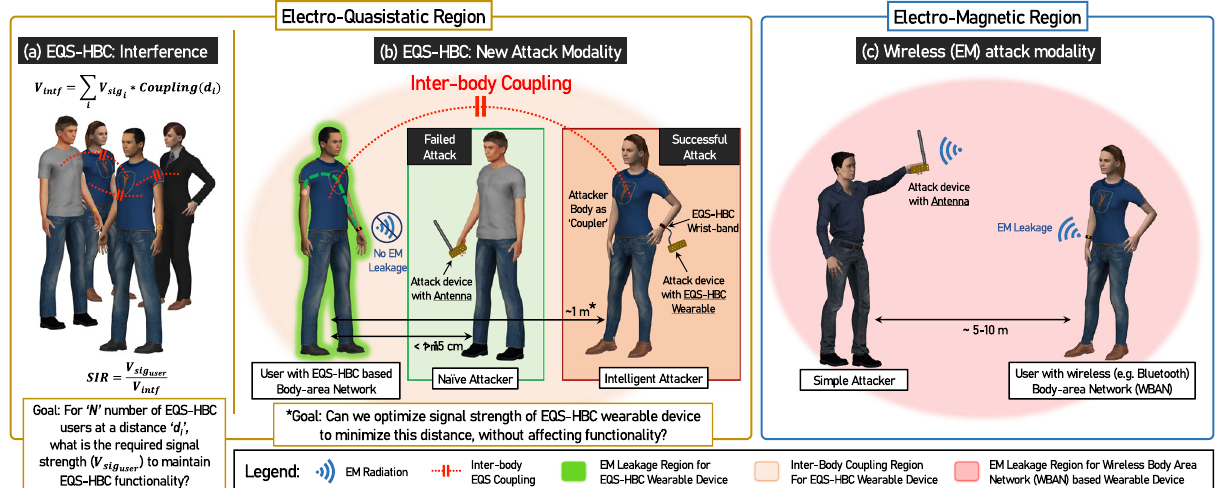
Figure 1. Inter-body coupling in Electro-quasistatic region: ( a ) Interference in received EQS-HBC signal due to inter-body coupling with other users. For multiple EQS-HBC users in close proximity, the received signal